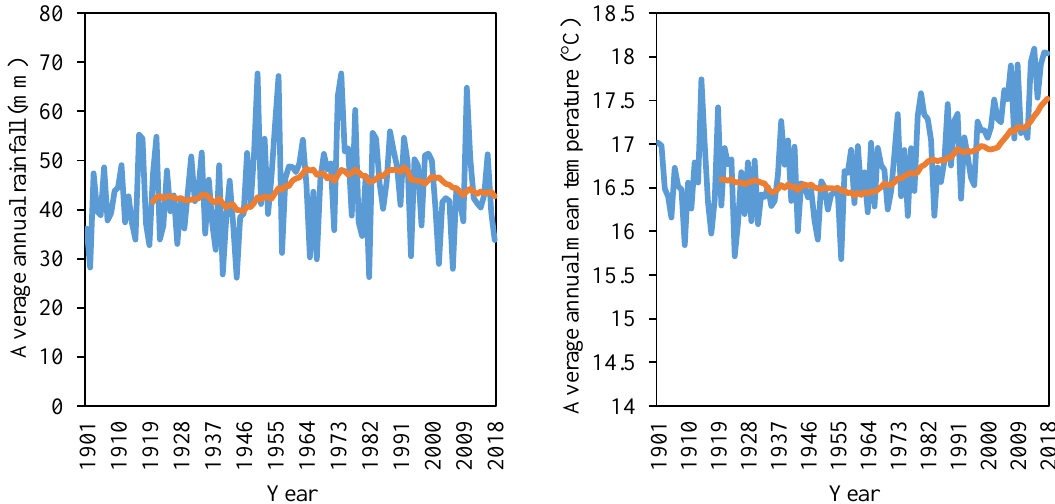
Figure 3. Variation of annual rainfall and mean temperature across the entire time duration (1901–2018) for the NSW region. The orange line represents the moving average of the past 20 years.